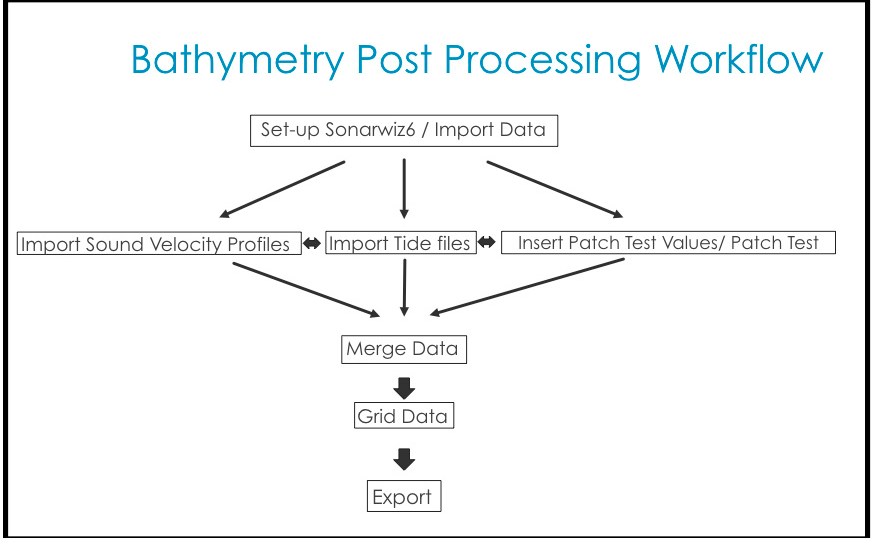
Figure 4. Schematic of workflow used by the University of Delaware mapping team for multibeam bathymetry data from EdgeTech 6205 acquisition to gridded data products. Data collected as part of a submerged mapping study for Assateague Island National Seashore in 2014–2015.